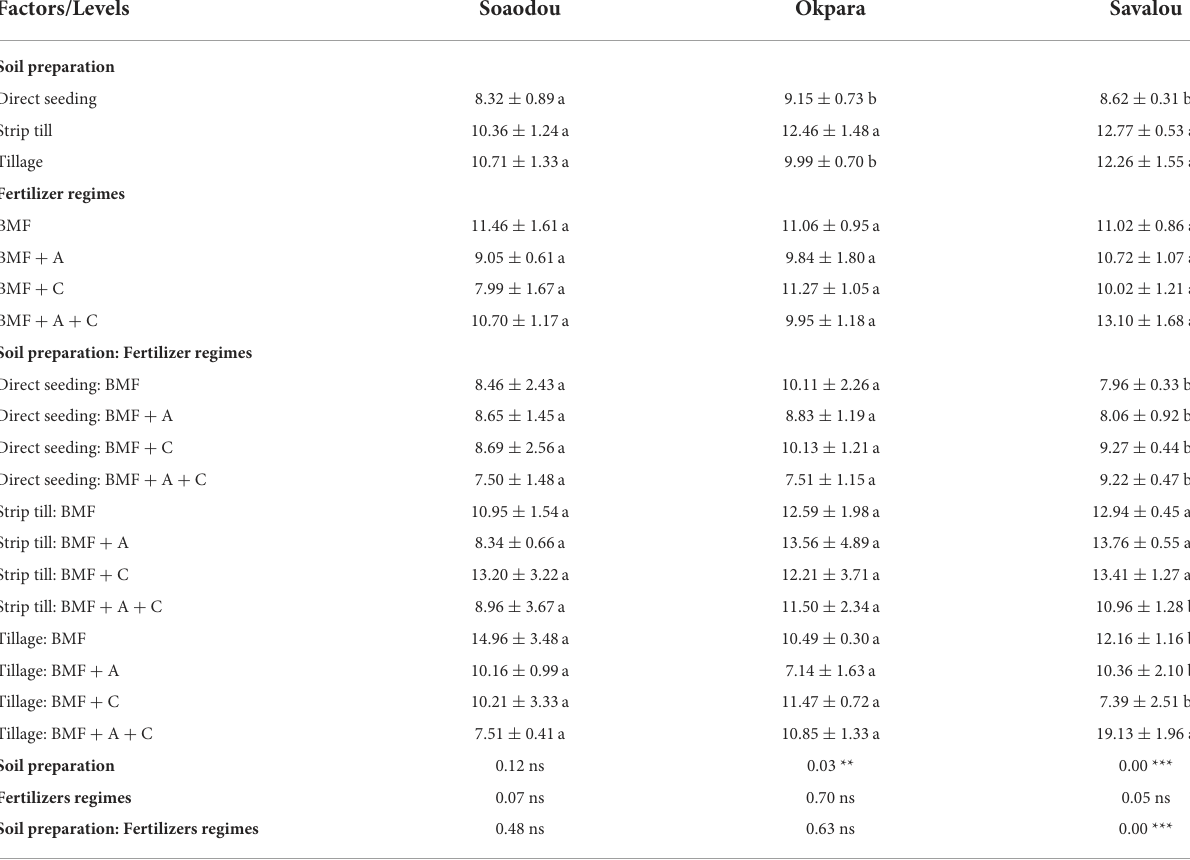
TABLE 3 Aboveground biomass (g plant − 1 ) at 40 days after emergence (means are followed by standard error).